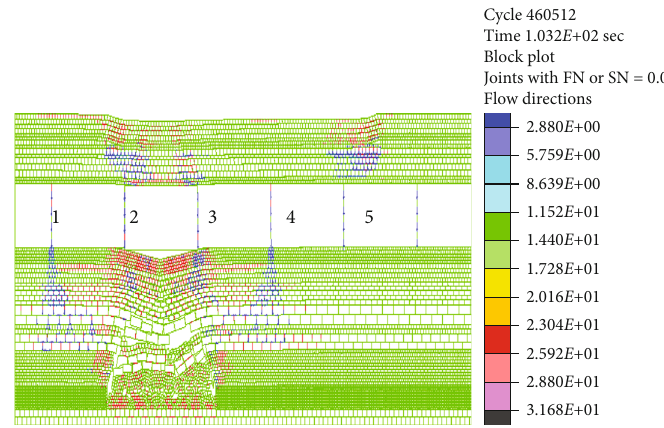
Figure 11: The fl ow velocity vector distribution in initial caving of key layer 2.